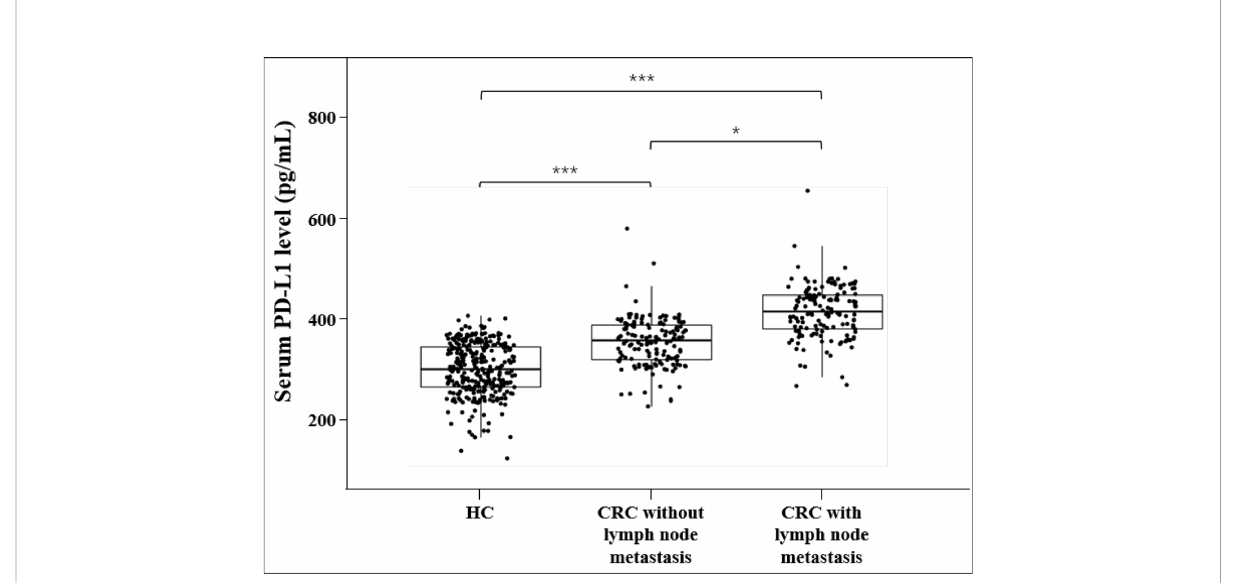
FIGURE 1 sPD-L1 levels in HC Group and CRC Group * p < 0.05, *** p < 0.001, Mann-Whitney U